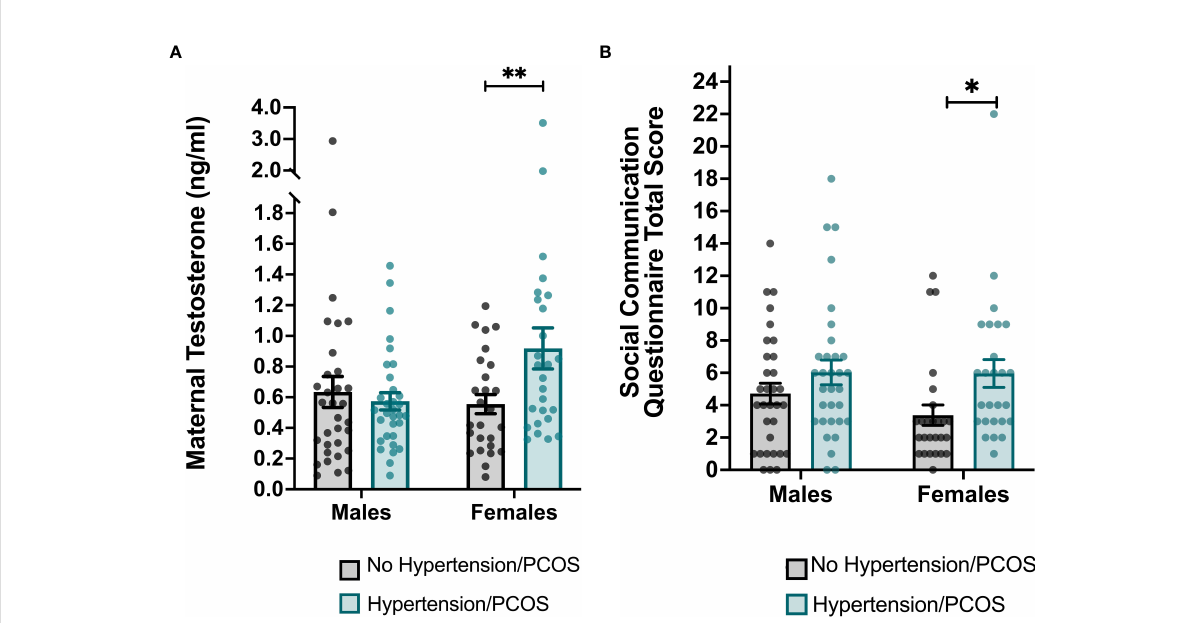
FIGURE 2 Group differences in maternal testosterone levels and total scores on the Social Communication Questionnaire (SCQ) strati fi ed by sex. (A) Maternal testosterone levels were signi fi cantly higher in women who were diagnosed with a hypertensive disorder of pregnancy and/or PCOS and who carried a female. (B) Total scores on the SCQ were signi fi cantly higher among female children born to women with a hypertensive disorder of pregnancy and/or PCOS. Each point represents an individual subject. Error bars represent the SEM. * p < 0.05, ** p ≤ 0.01.